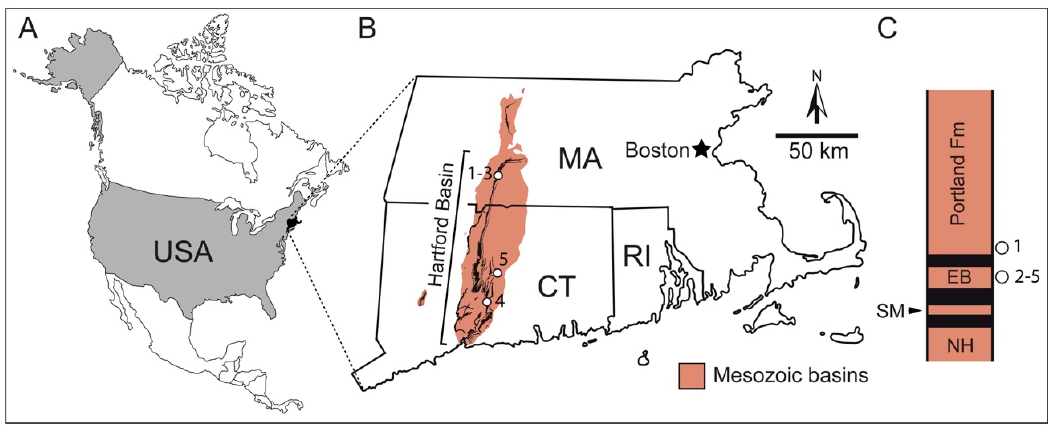
Figure 1. Geographical and geological context of the dinosaur track sites discussed herein. ( A ) Map of North America showing the United States in gray and southern New England in black; ( B ) Inset showing the distribution of Mesozoic basins belonging to the Newark Supergroup in southern New England; ( C ) Simplified stratigraphic column of the Hartford Basin showing the approximate position of the different sites. Numbers for the sites are as follows: 1, Dinosaur Footprint Reservation; 2, William Murray Quarry; 3, Gary Gaulin Tracksite; 4, Powder Hill Dinosaur Park; 5, Dinosaur State Park. Abbreviations in ( B , C ) are: CT, Connecticut; EB, East Berlin Formation; MA, Massachusetts; NH, New Haven Formation; RI, Rhode Island; SM, Shuttle Meadow Formation. Table 1. Summary of dinosaur footprint localities examined for this study. DFR: Dinosaur Footprint Reservation; WMQ: William Murray quarry; GGT: Gary Gaulin tracksite; PHDP: Powder Hill Dinosaur Park; DSP: Dinosaur State Park.